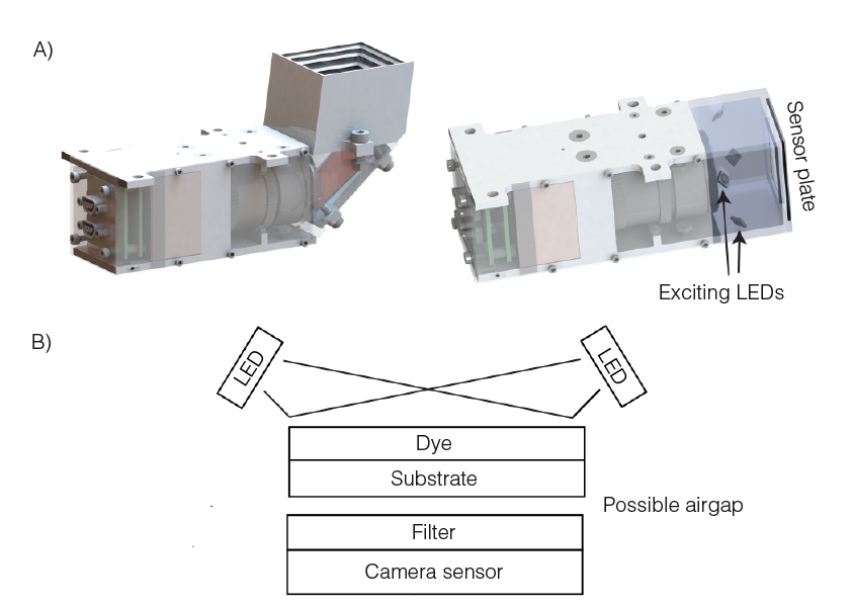
Figure 14. Two concepts of the device: ( A ) a larger device based on the OPIC instrument and having parts that are already space-qualified, and ( B ) a more space-efficient device, which requires more research to be applied in